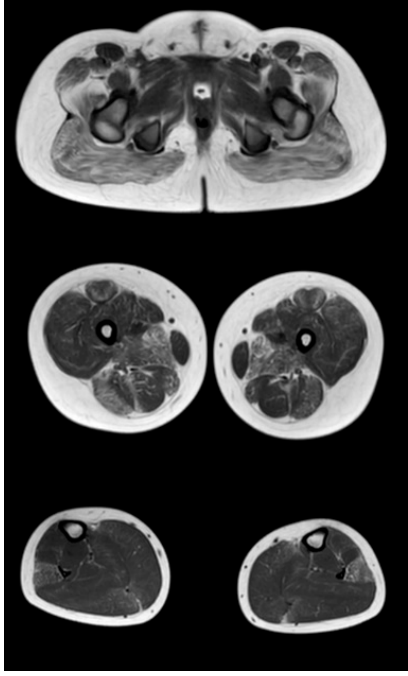
Figure 4. Pattern of involvement of the muscles of the lower extremities in a patient at the late outpatient stage of the disease (9.4 years). From top to bottom: the pelvic level, the femoral level, and the level of the legs.